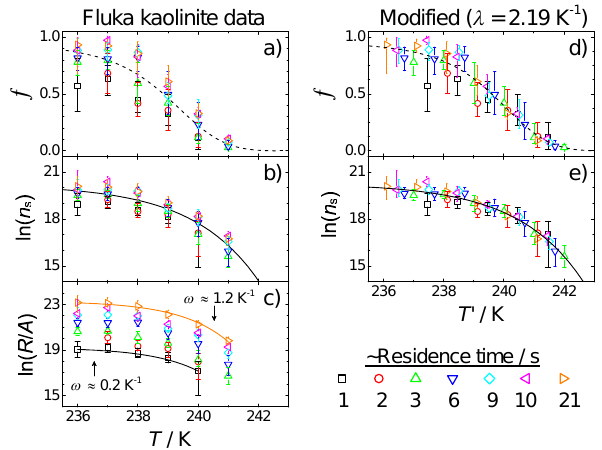
Figure 8. The freezing of droplets containing size-selected 400nm kaolinite (Fluka) particles in a CFDC instrument from Welti et al. (2012). Layout as in Fig. 5. Residence times at constant tem- perature ranged from 1.11 to 21.4s at temperatures from 236 to 241K. R/A(T ) values, shown in (c) , do not fall onto a single line and exhibit a consistent separation with increasing residence time. Modified n s (T 0 ) data were minimised in order to determine a value of λ that best describes the time dependence, resulting in λ = 2.19K − 1 . The minimised n s (T 0 ) values and corresponding fit (RMSE = 0.047) are shown in (e) . For comparison the same fit- ting function was applied to the raw n s (T ) data (RMSE = 0.076) and is shown in (b) . These two functions were used to reproduce a 1Kmin − 1 cooling experiment and are shown as dashed lines in (a) and (d) . Error bars are reproduced from Welti et al.